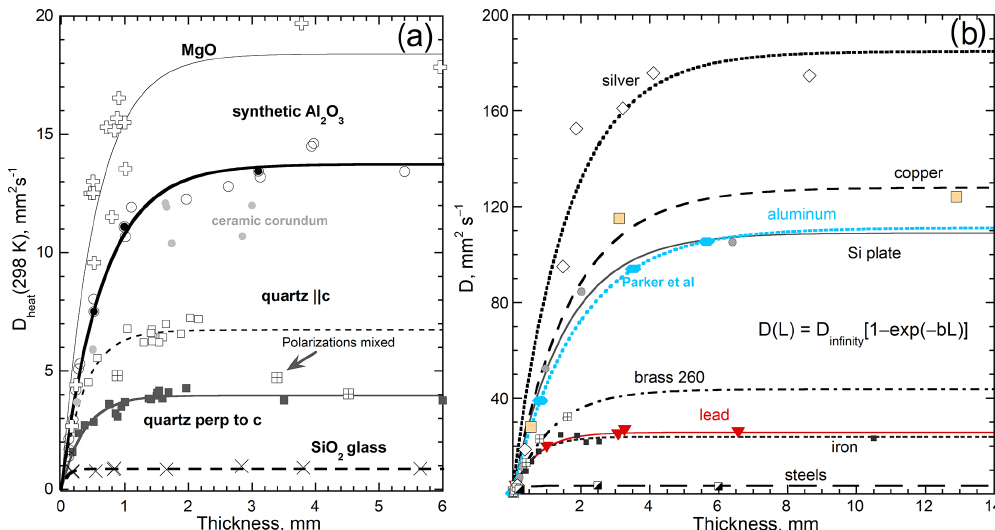
Figure 1. Dependence of thermal diffusivity at 298K on thickness, for various samples, as labeled. Fits are least squares. (a) Insulators with simple compositions. Parallel and perpendicular orientations are shown for quartz. After Hofmeister (2019) – this is the revised and augmented version in Hofmeister (2021). (b) Nearly pure elements and two alloys. At low thickness, the trends are linear and converge.